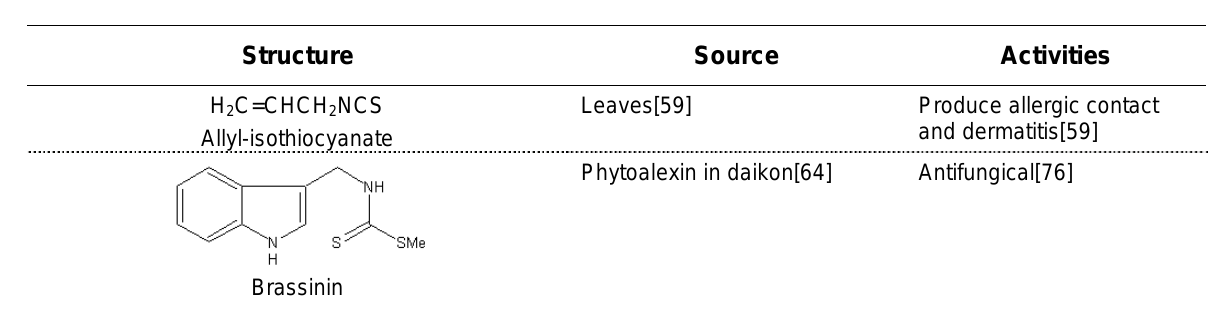
Sulfur Isolated from